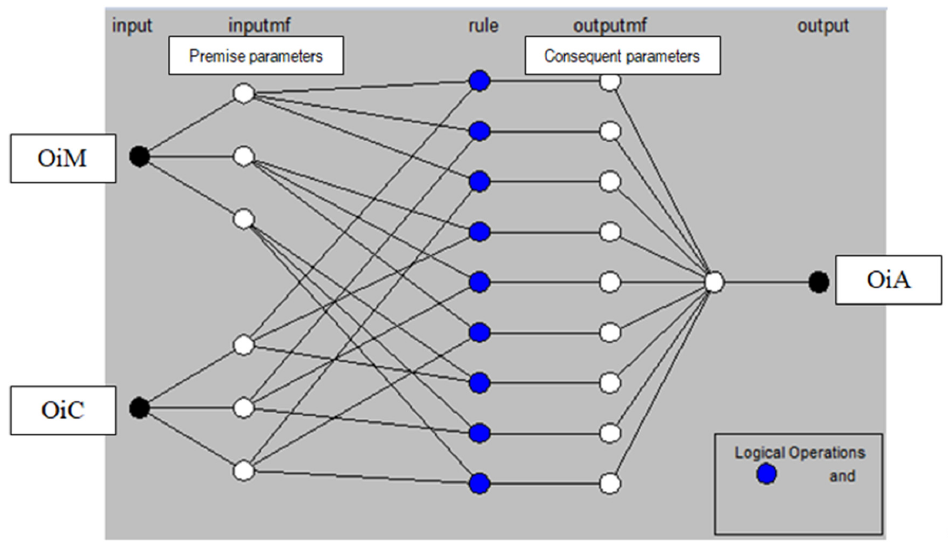
Figure 7. The ANFIS structure for the OiA outcome.